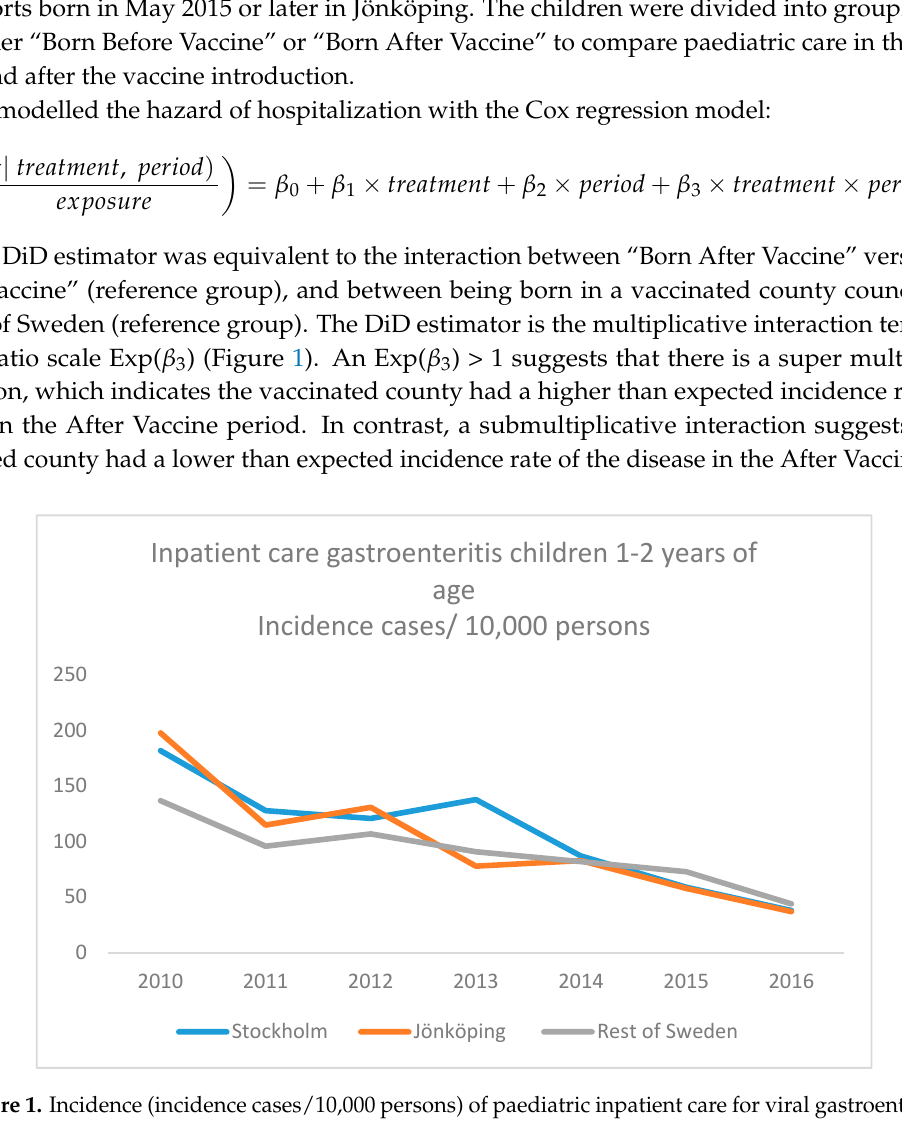
Figure 1. Incidence (incidence cases/10,000 persons) of paediatric inpatient care for viral gastroenteritis in Swedish children aged 12–24 months during 2011–2016.